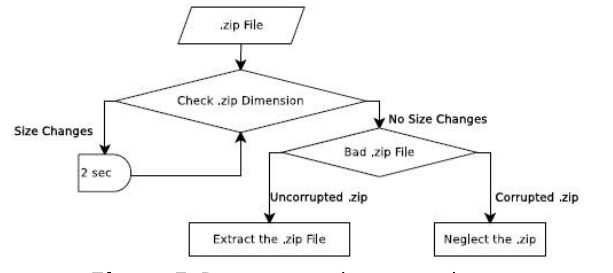
Figure 5 . Decompression procedure.